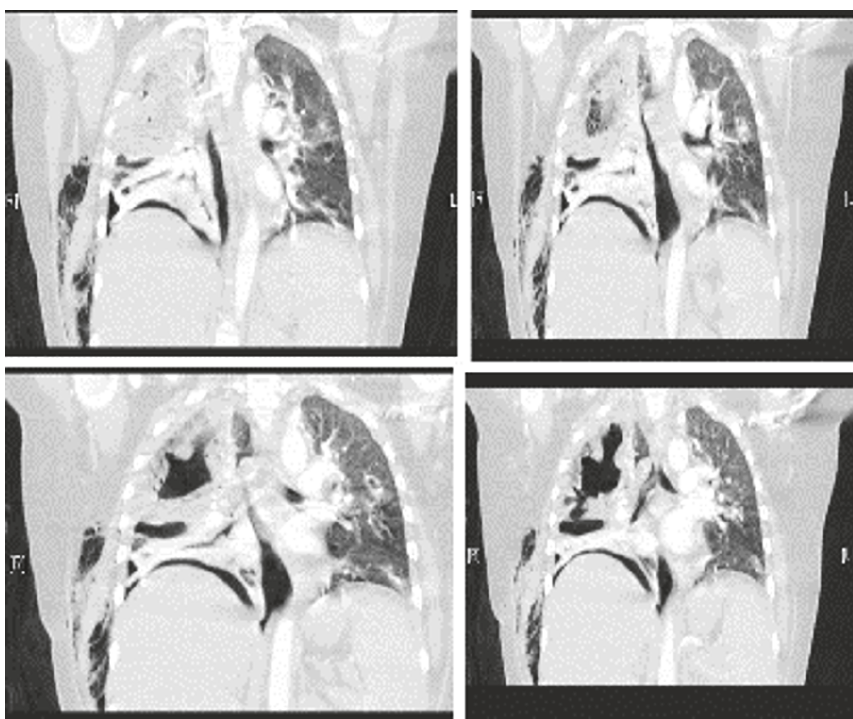
Figure 2: Chest computed tomography revealed multiple bilateral cavitation (more on the right), moderate right-sided pleural effusion, air-space infiltrates, and a right-sided cavitary-pleural communication.